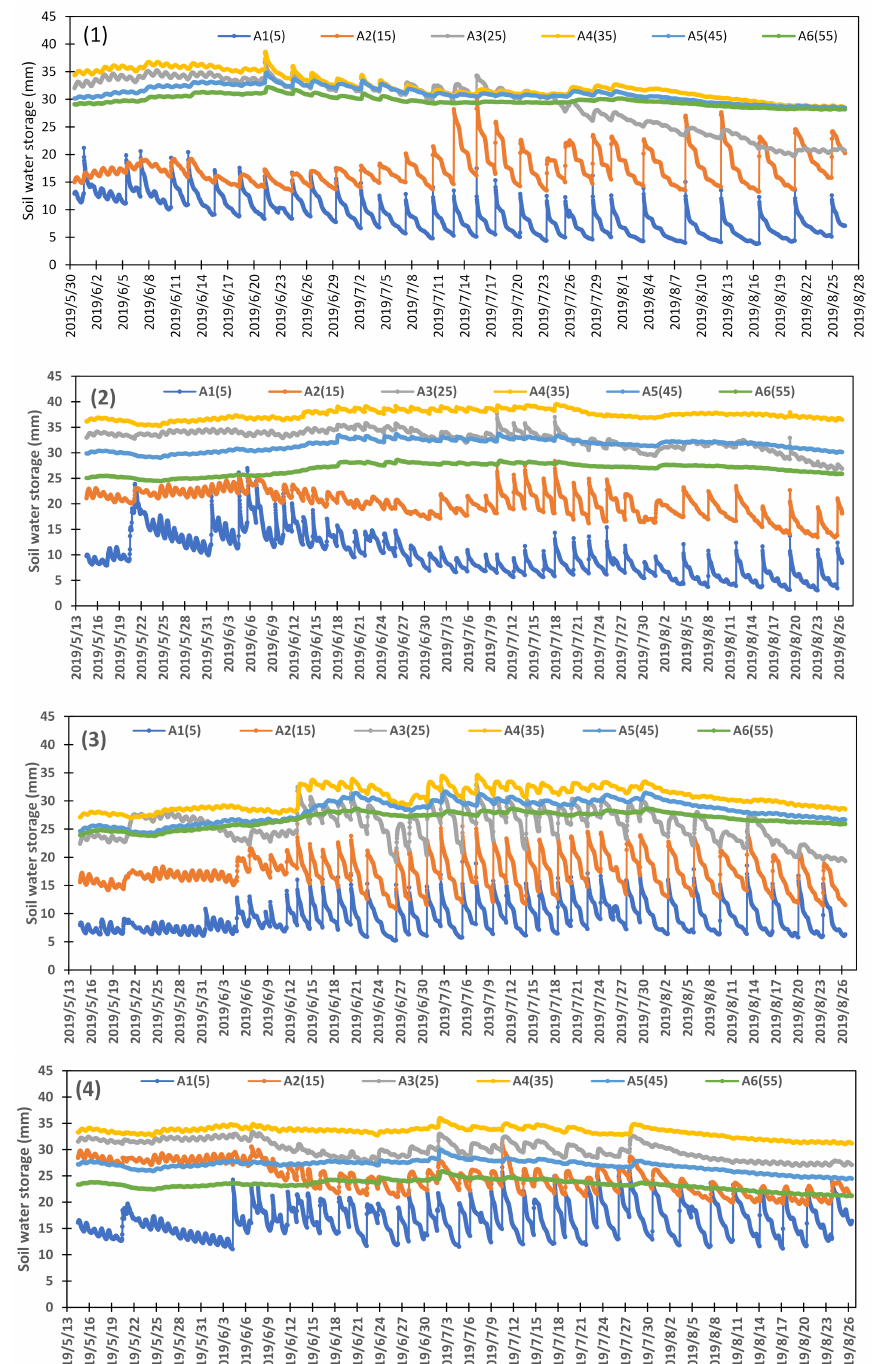
Figure 7. Soil water dynamics in four commercial potato fields during the 2019 growing season at 5 cm (A1), 15 cm (A2). 25 cm (A3), 35 cm (A4), 45 cm (A5), and 55 cm (A6) below the soil surface. ( 1 ) Field 1; ( 2 ) Field 2; ( 3 ) Filed 3; ( 4 ) Field 4; ( 5 ) Field 5. The monthly total applied irrigation for the five fields in 2018 and the four fields in 2019 averaged 22.02, 17.78, 107.18, 233.68, 195.07, 144.78, and 45.72 mm in March, April, May, June, July, August, and September (Figure 8). The average seasonal applied irrigation amount was 777.23 ± 35.51 mm. The applied irrigation amount in March is a preplant one and helps improve soil work and seedbed